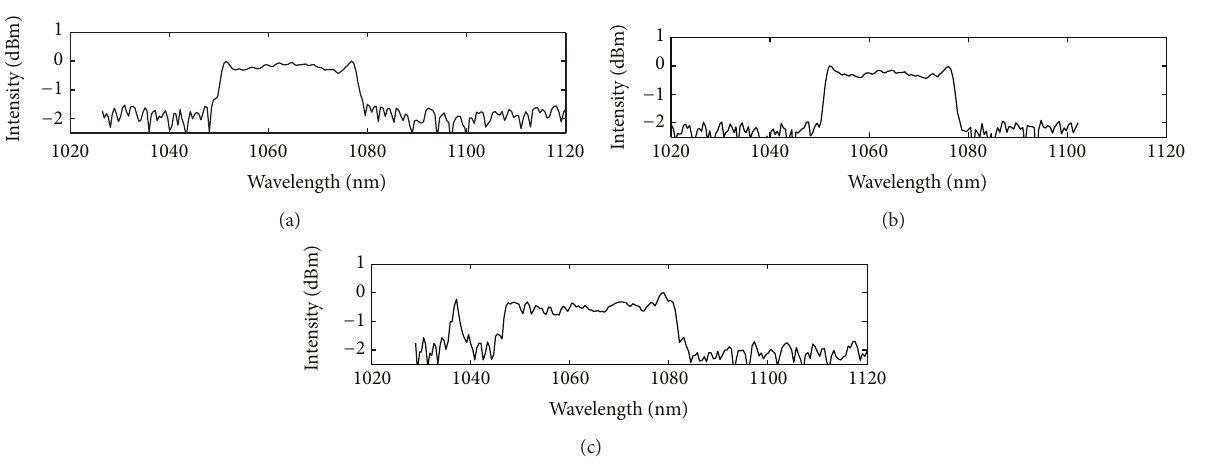
Figure 4: Optical spectra of the (a) fundamental mode-locked, (b) second-harmonic mode-locked, and (c) third-harmonic mode-locked pulses.